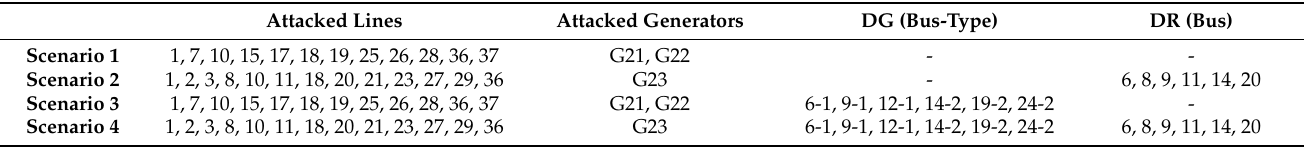
Table 15. Attacked elements and use of